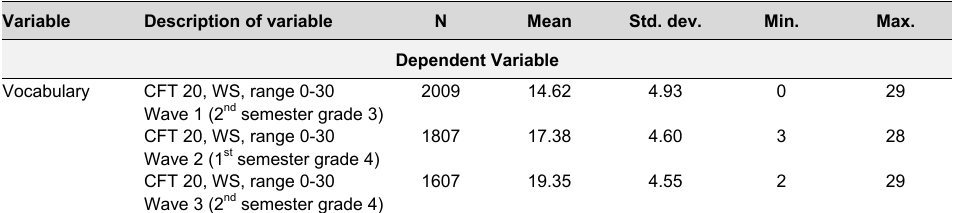
Description of variables